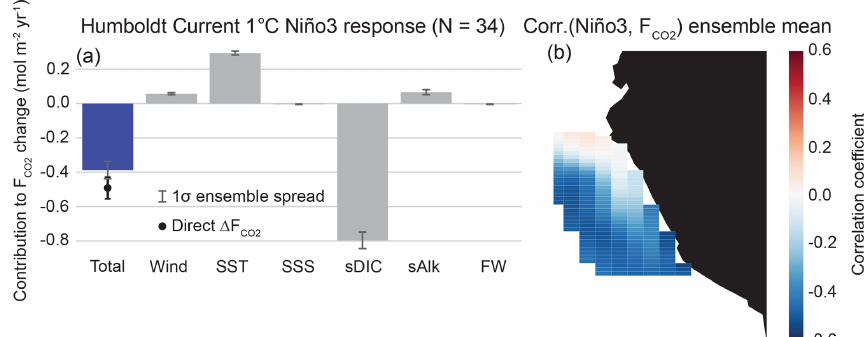
Figure 8. As in Fig. 6, but for the Humboldt Current response to the Niño3